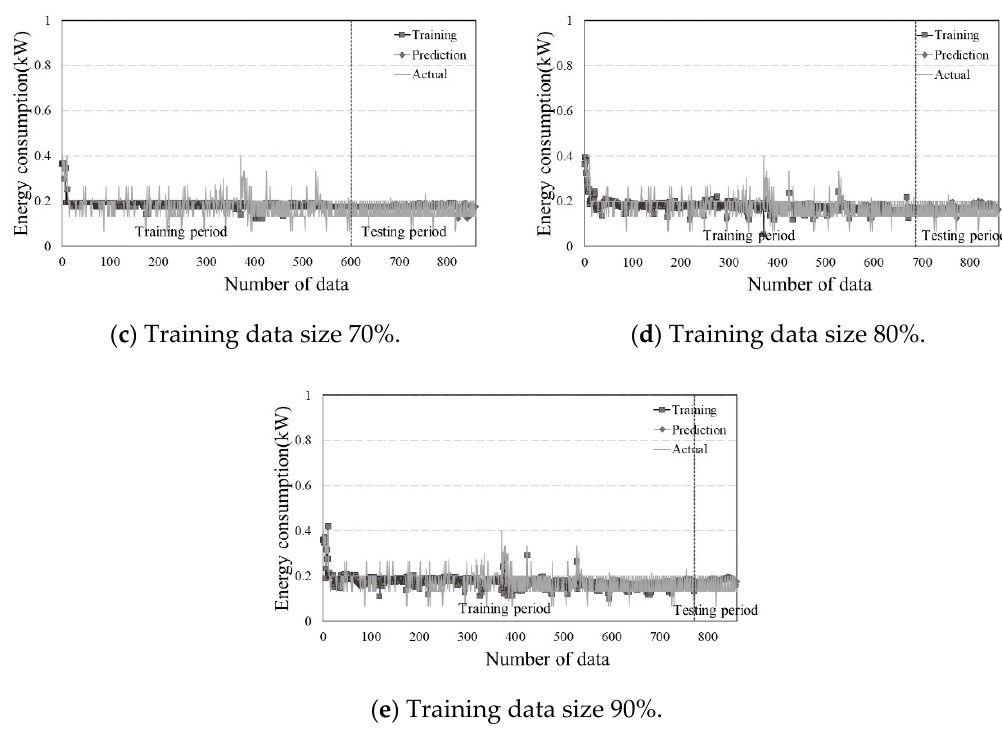
Figure 6. Absorption chiller energy consumption forecast results. Table 5. Absorption chiller energy consumption forecasting results: error rate and standard deviation.